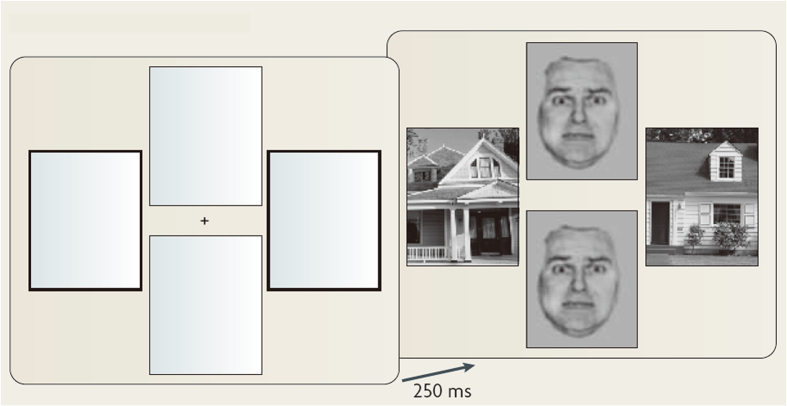
Experimental paradigm.The first display presents four empty frames in the vertically and horizontally paired positions, with either the two horizontal or the two vertical frames being highlighted. The next display shows a central fixation point followed by paired faces and paired houses arranged in vertical or horizontal positions. The two highlighted frames always predict the locations of the paired houses in the present study. Participants were required to attend to the paired houses preceded by the two highlighted frames and to judge whether the houses were the same or different. Both faces had either neutral or fearful expressions. The positions of the paired faces or houses (vertical or horizontal) and the facial expressions (neutral or fearful) were counterbalanced across subjects and were presented in a random order. The figure is reprinted with permission from the ref. 5 © Macmillan Publishers Ltd., in Nature Publishing Group. The figure is a modified version of the original figure from the ref. 8 © Cell Press.